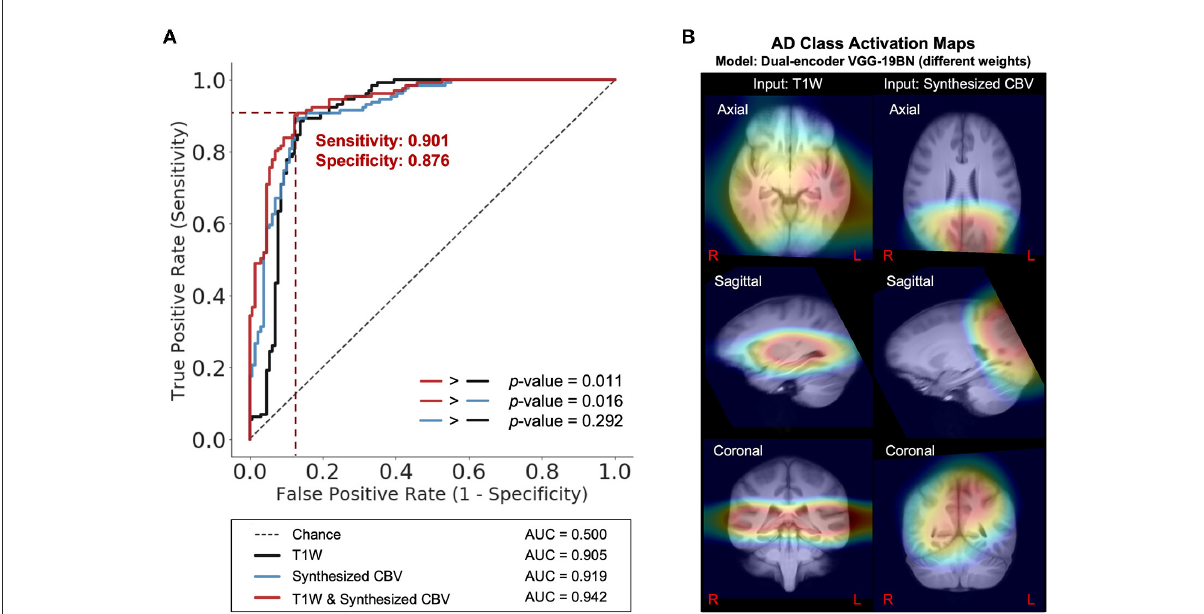
FIGURE7 DeepContrast-generated synthesized CBV improves AD classification and provides spatially-meaningful information. (A) Receiver Operating Characteristics curves for the classification models using T1W structural data only (black), using synthesized CBV functional data only (blue), or using both in combination (red). p -values were calculated using DeLong’s test. (B) The class-average Class Activation Maps of the best-performing model, calculated from 131 AD scans in the standalone test set.